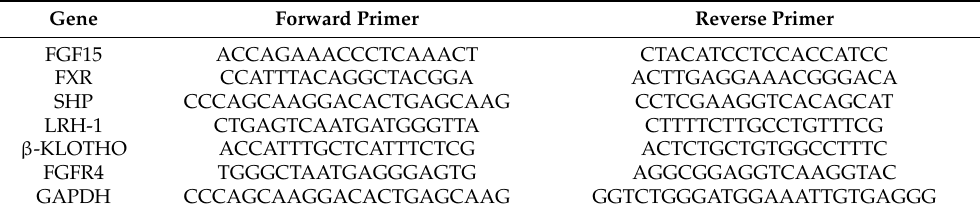
Table 2. Primer sequences of the genes used for